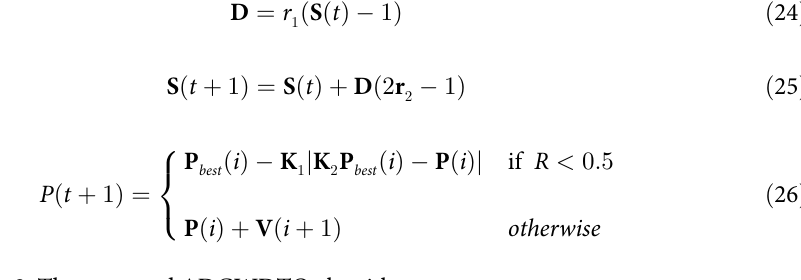
Algorithm 3 : The proposed ADGWDTO